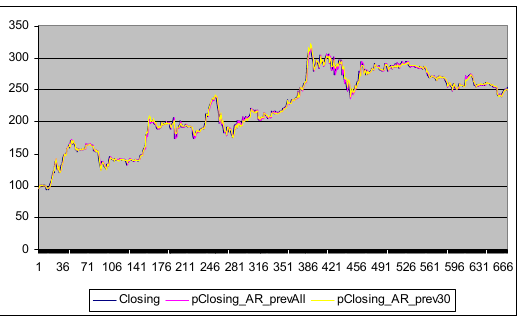
Figure 9: Company